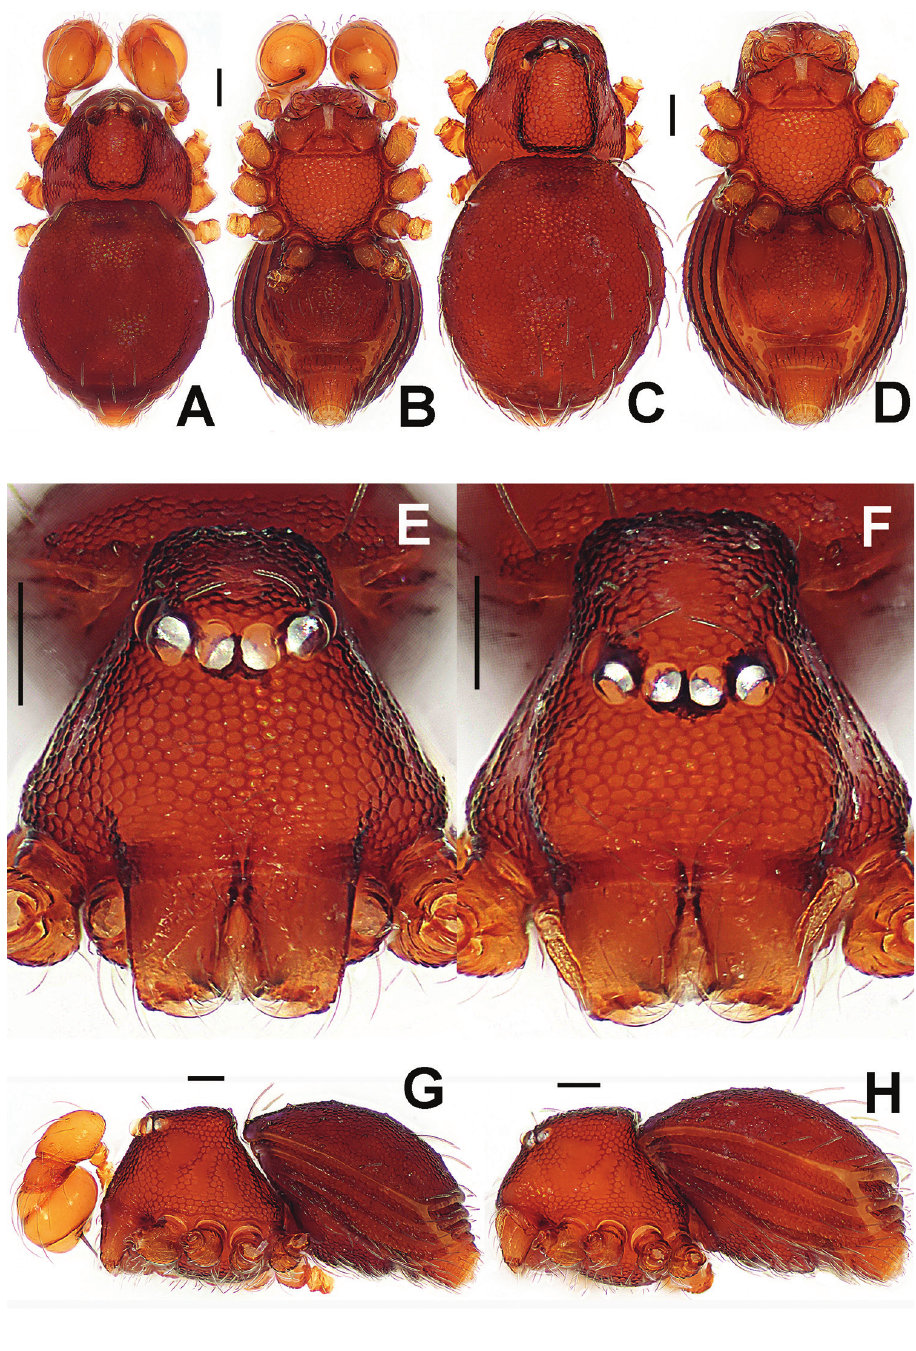
Figure 16. Singaporemma lenachanae sp. n., male holotype ( A–B, E, G ) and female paratype ( C–D, F, H ). A–D, G–H habitus E–F prosoma. A, C dorsal B, D ventral E–F anterior G–H lateral. Scale bars: 0.10